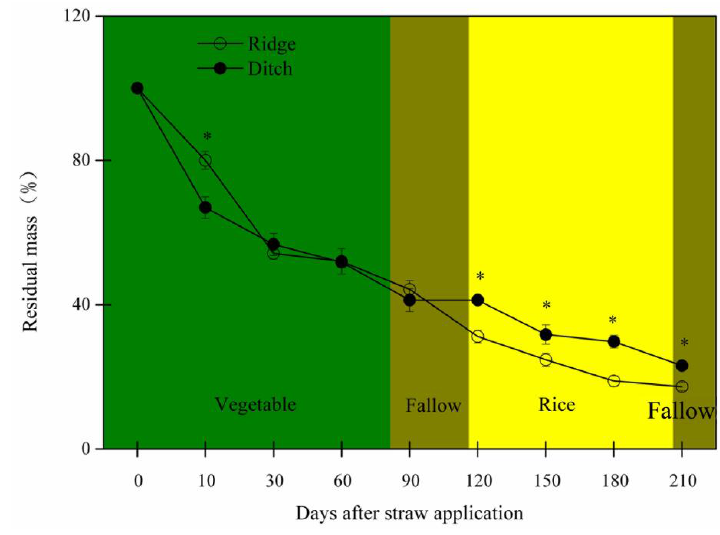
Figure 2. Residual straw mass during rice straw decomposition. Statistically significant differences ( p < 0.5) between ridges and ditches in each sampling date are highlighted with (*).